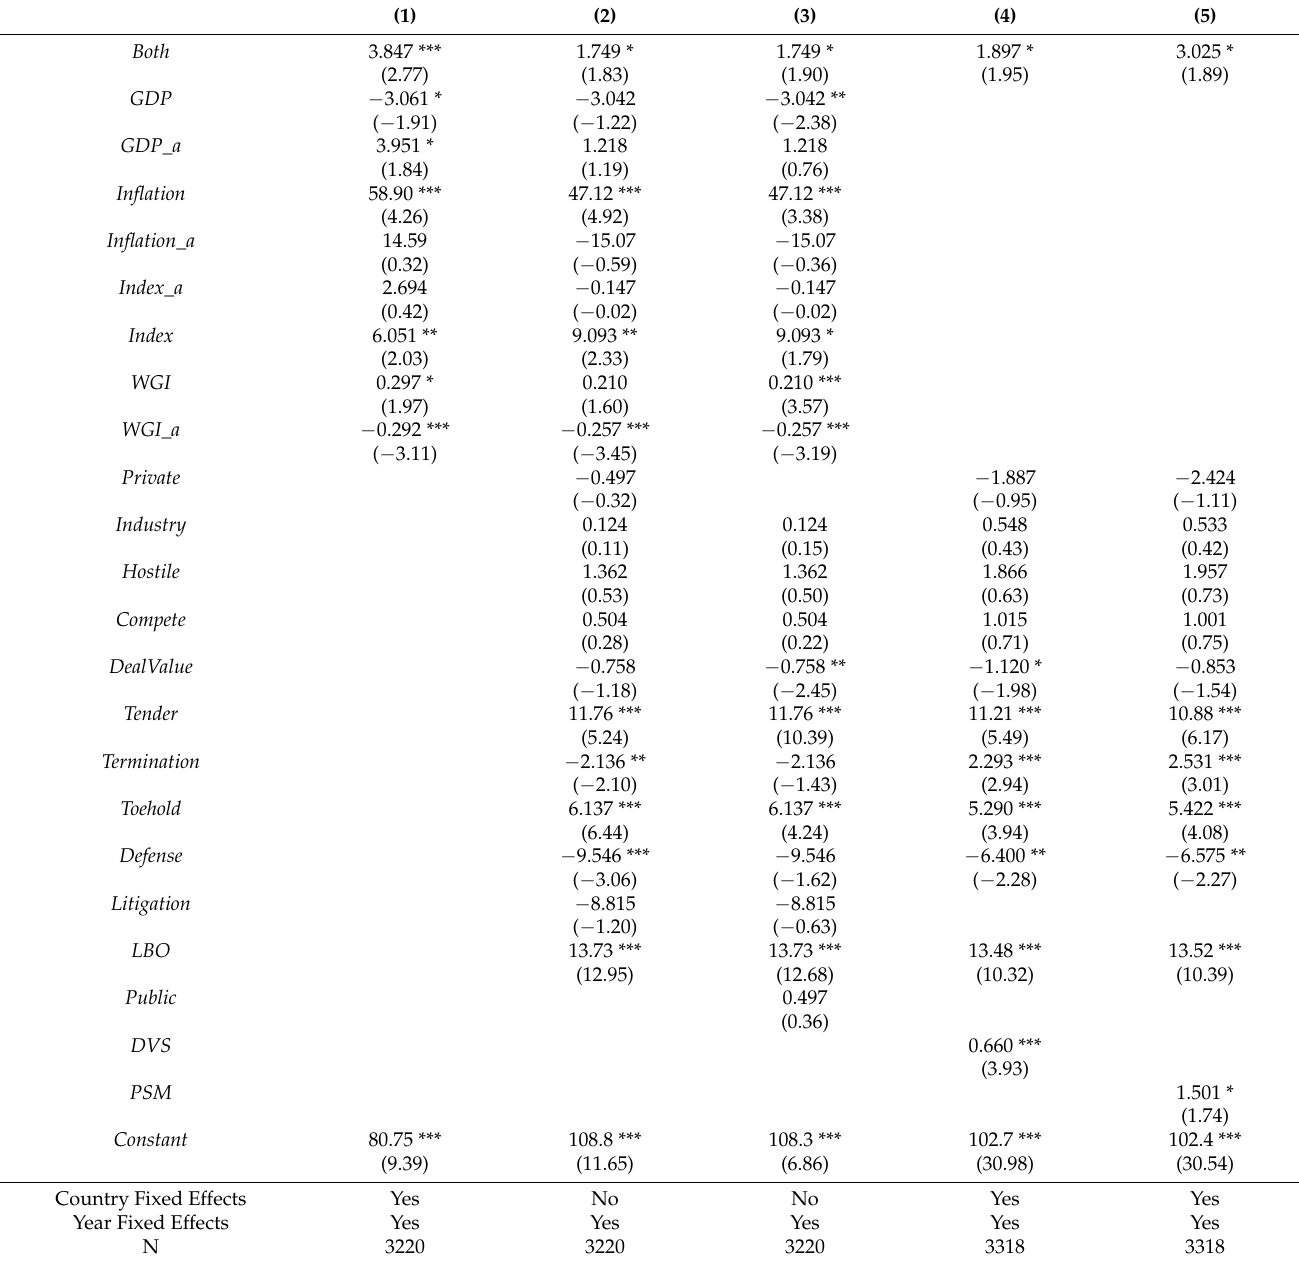
Table A5. This table presents the results of OLS regressions run on the ‘same region’ subsample. The subsample includes only cross-border deals that took place where the acquirer and target countries are domiciled within in the same region. The regions used were: North America, Asia Pacific, Europe, Latin America, Middle East and Africa. The dependent variable is CashPaid and the main independent variable of interest is Both which is an indicator variable that equals 1 if social media is popular in both the acquirer and target countries. Models 1, 2 and 3 control for macroeconomic variables of both the acquirer and target nations. Models 2 to 5 control for deal-level variables specified above. Standard errors are double-clustered by country and